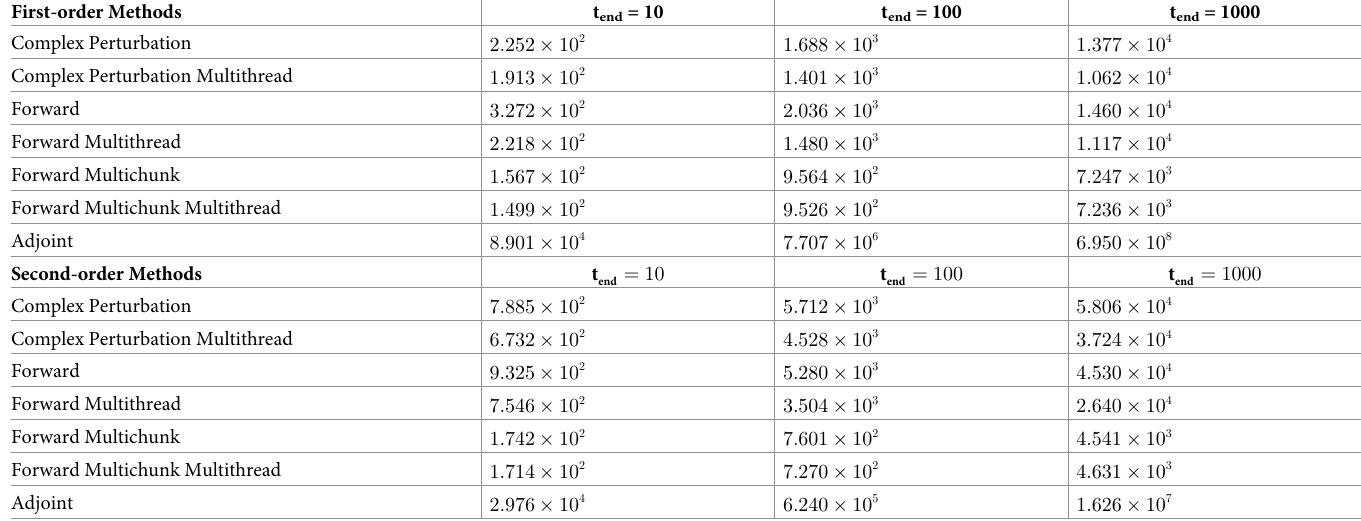
Table 2. Computational time ( μ s) for the SIR ODE model. Parameters match those previously introduced in this manuscript. Multithread refers to parallelism across parameters. Multichunk refers to parallelism across compartments. We invoke the Julia solver AutoVern9(Rodas5(autodiff = false)) with a tolerance of 1 × 10 − 5 , reflecting the convergence tolerance. For the second-order adjoint method, the ForwardDiffOverAdjoint(QuadratureAdjoint(autodiff = false) solver option was used.